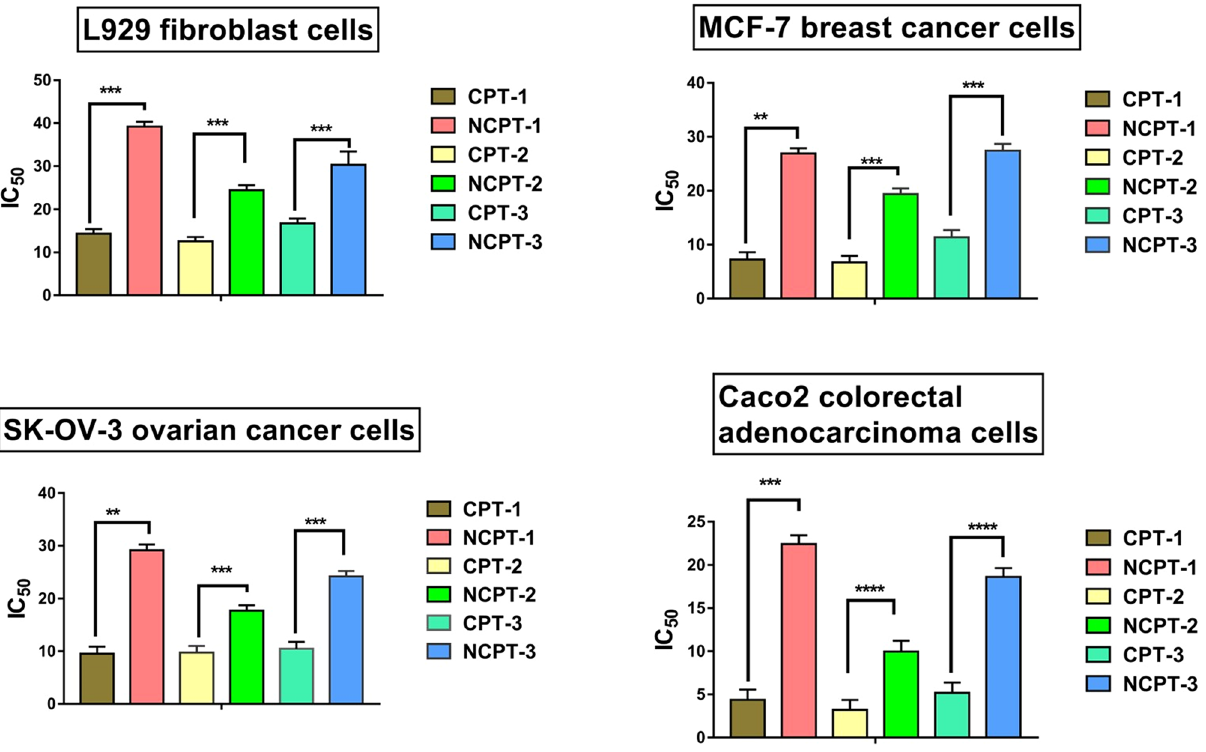
Figure 5. Comparison of cytotoxicity between camptothecin producing strains ( CPT1, CPT2 and CPT3) and non-camptothecin producing strains (